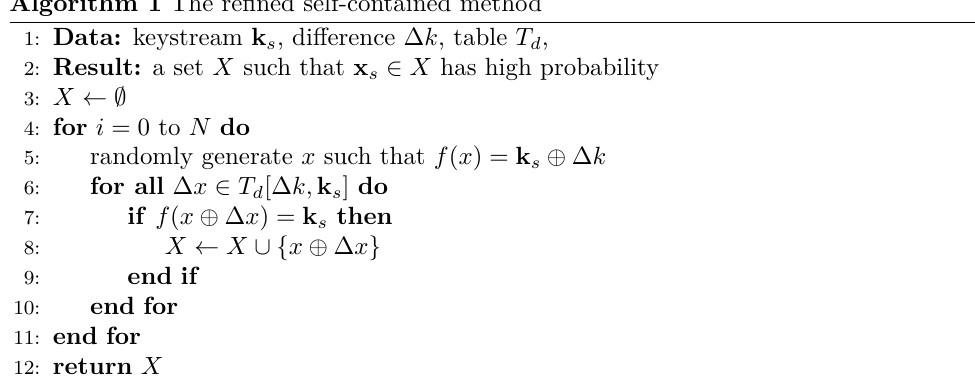
Algorithm 1 The refined self-contained